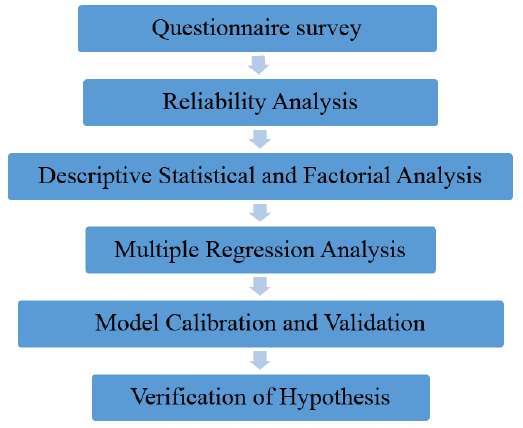
Figure 3. Analysis framework flowchart.